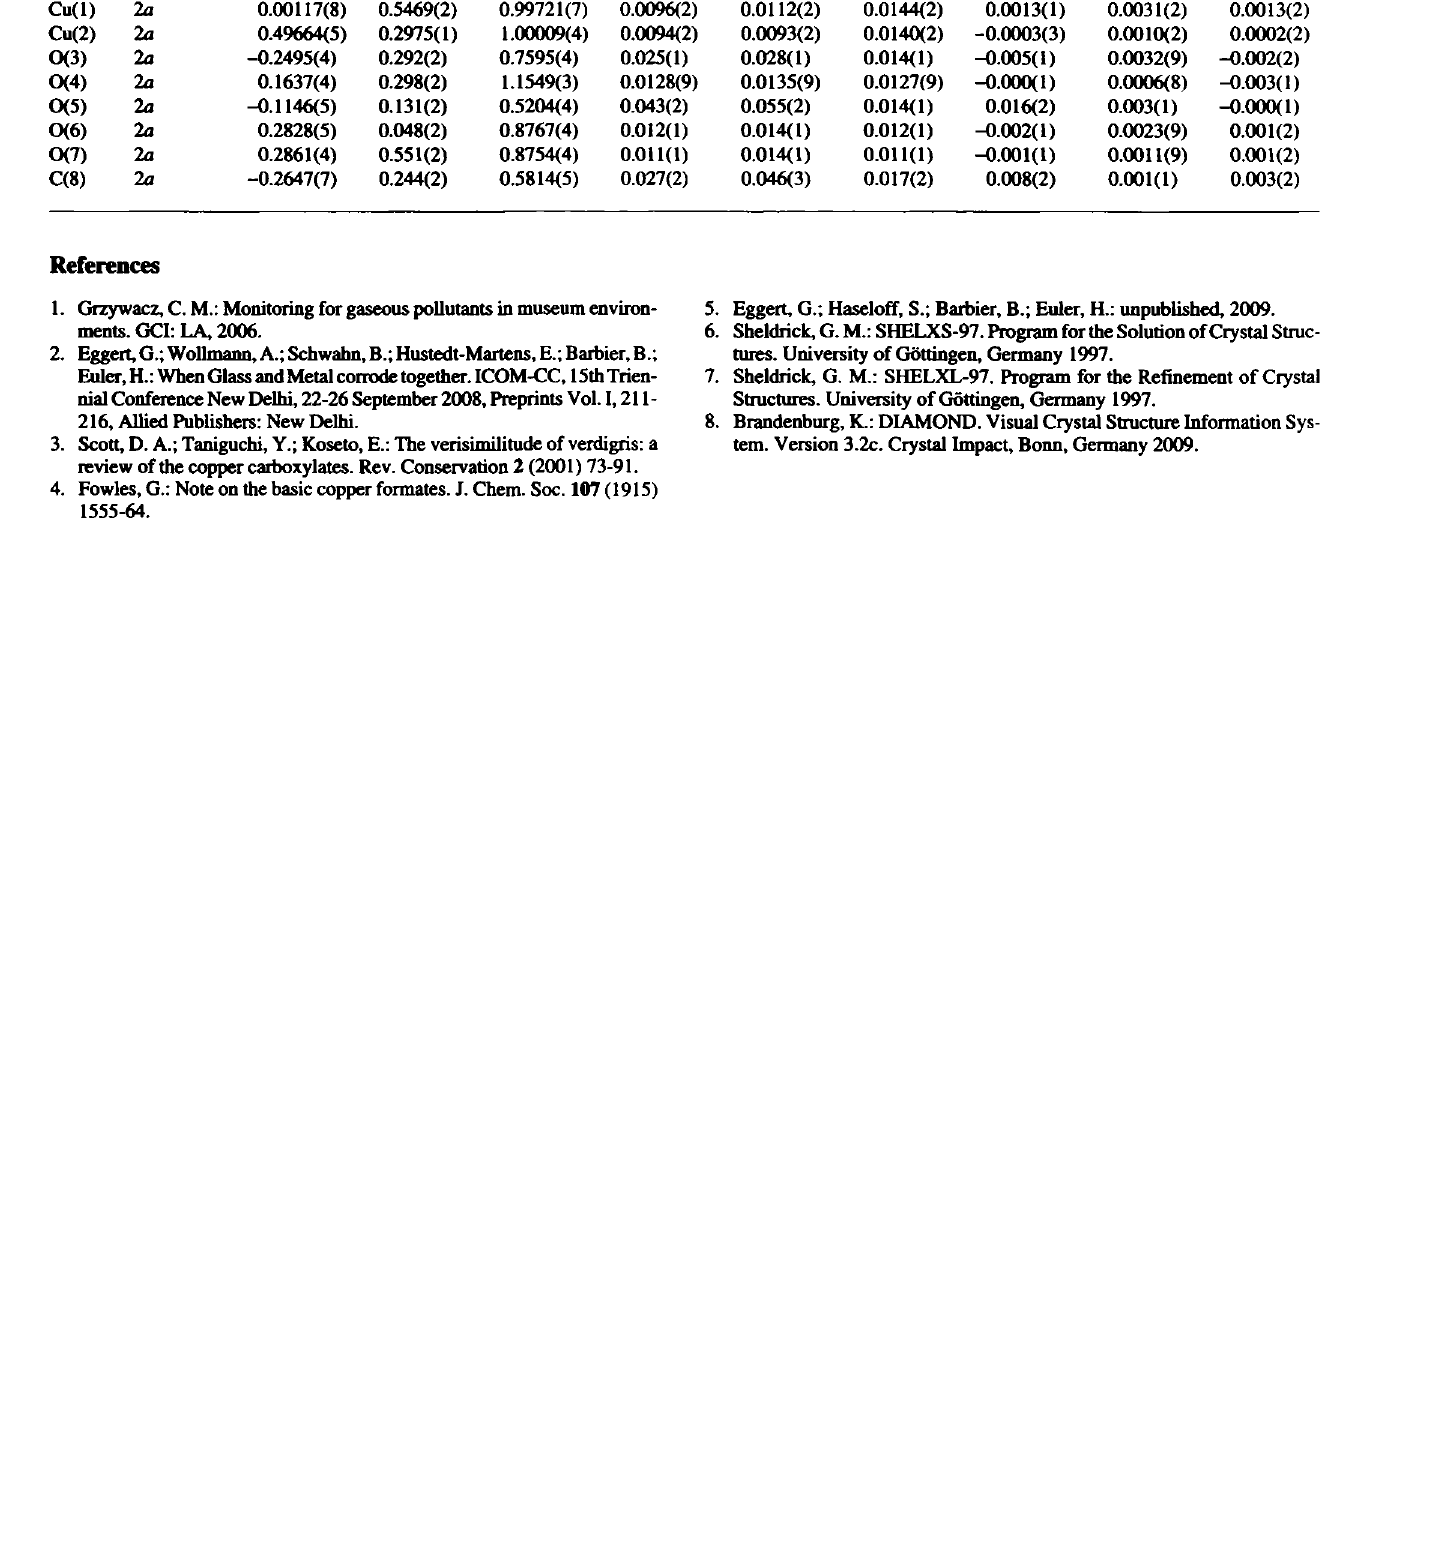
Table 3. Atomic coordinates and displacement parameters (in Â 2